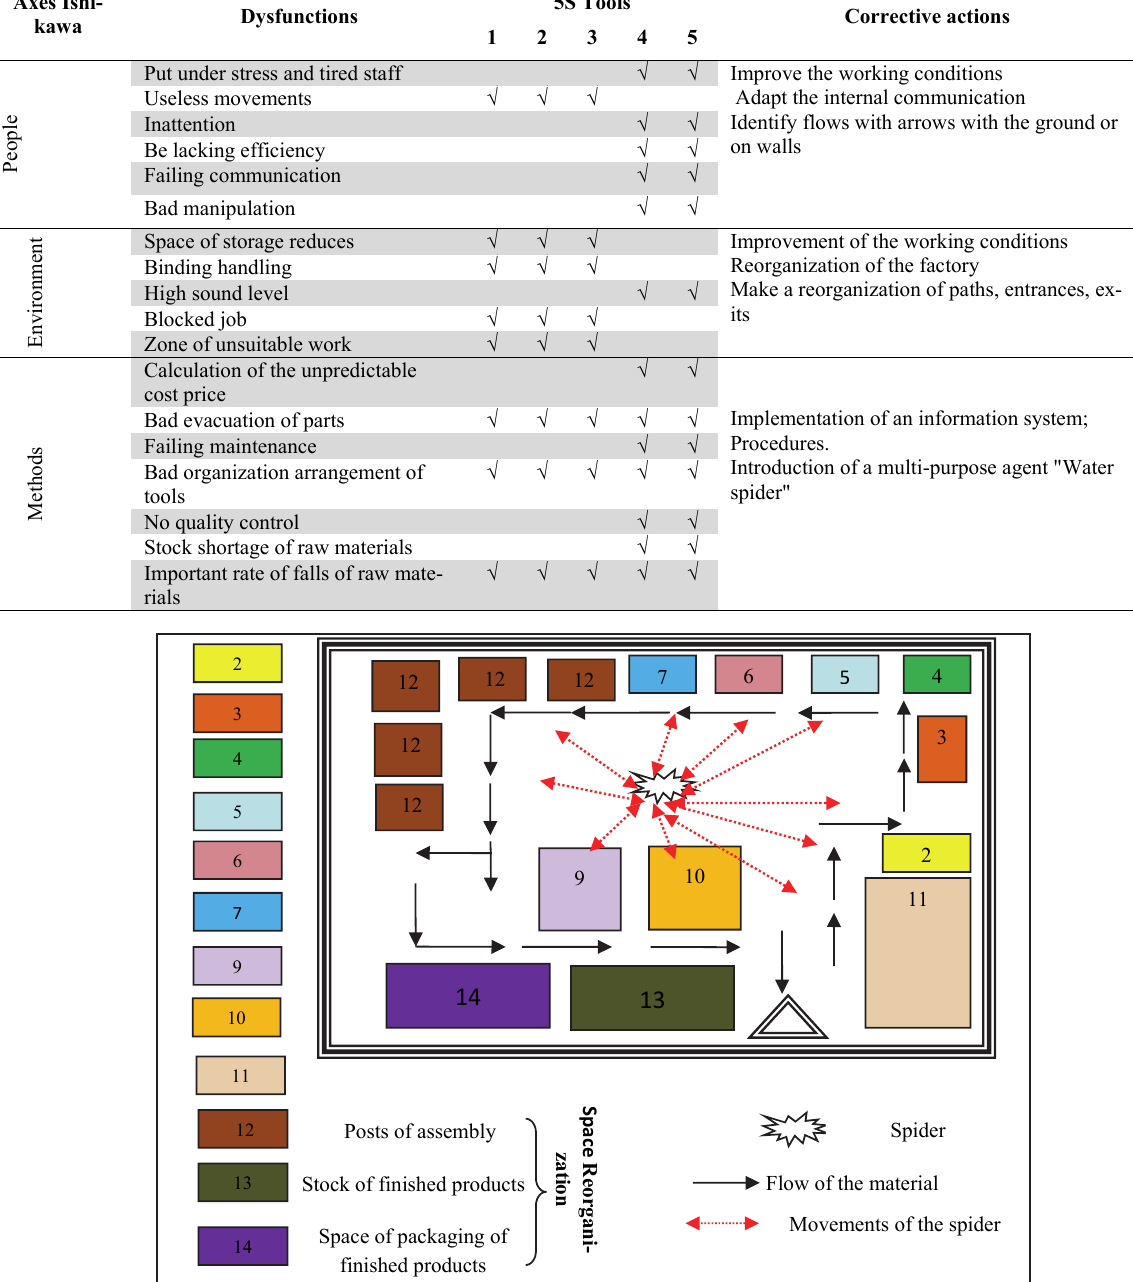
Fig.5. New organization of the